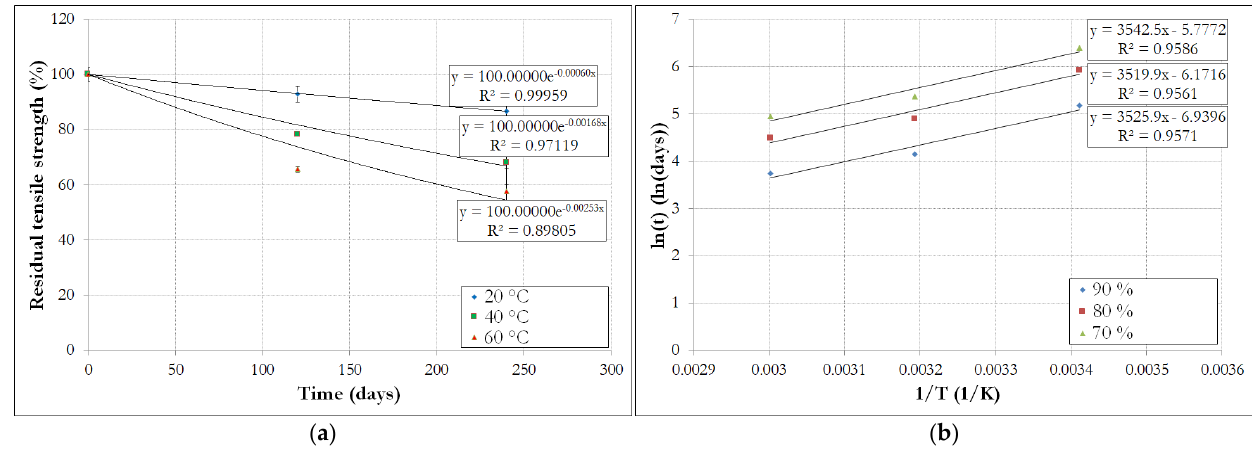
Figure 14. ( a ) Residual tensile strengths of GRP bars as a function of direct aging time and ( b ) Arrhenius lines for different retention rates of the tensile strength.